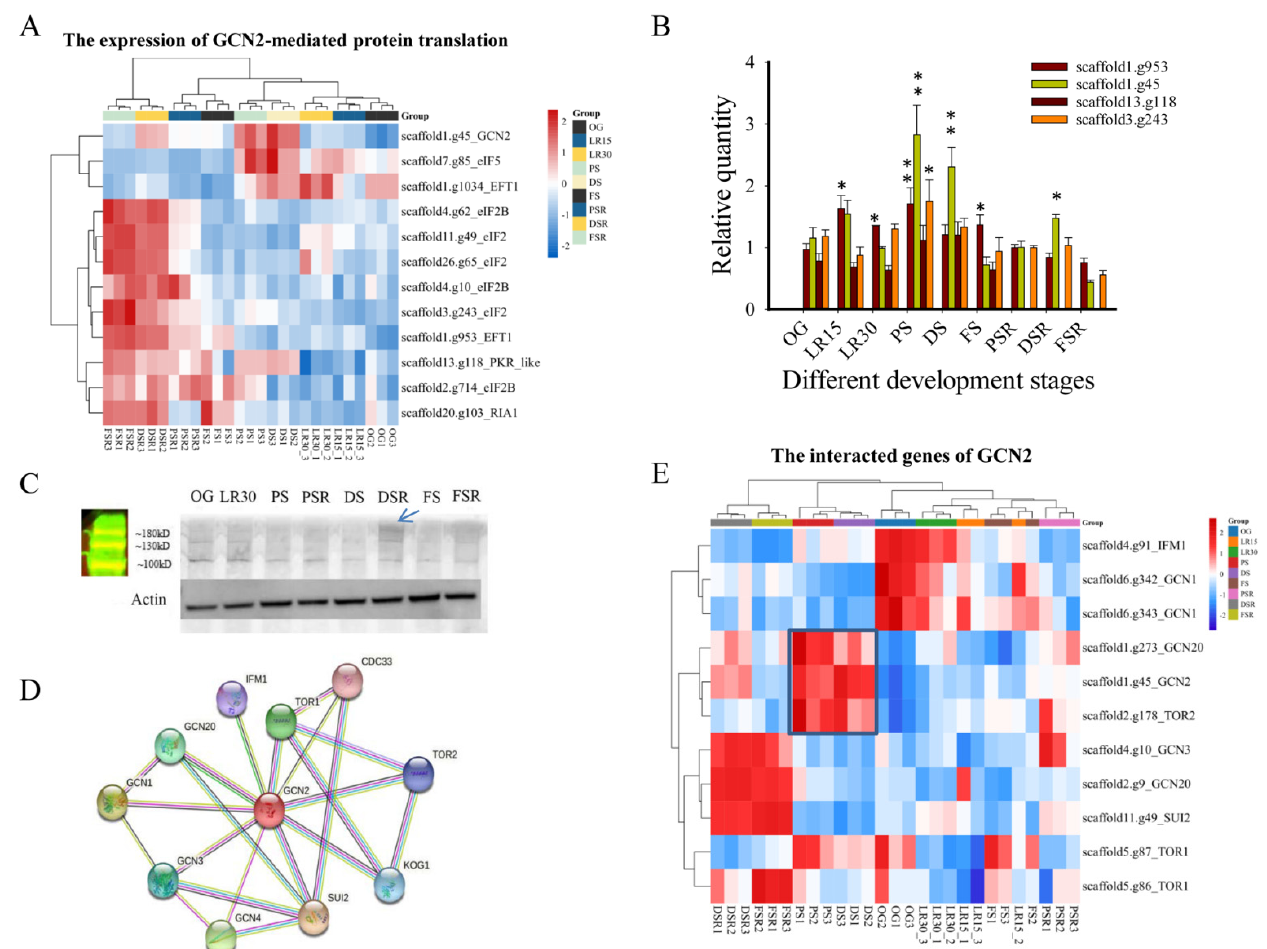
Figure 5. GCN2-mediated translation regulation in low-temperature fruiting after long postripening (LFLP) in H. marmoreus . ( A ) Heatmap analysis of key genes in GCN2-mediated translation control in H. marmoreus at different developmental stages. ( B ) qPCR analysis of GCN2 and eIF2 in LFLP of H. marmoreus. * indicates p < 0.05; ** indicates p < 0.001. ( C ) Western blot experiment of GCN2 in LFLP. Arrow: the enriched GCN2 with expected MW 160 kD. ( D ) Analysis of GCN2-interacting genes. ( E ) Heatmap analysis of the interacting genes of GCN2.